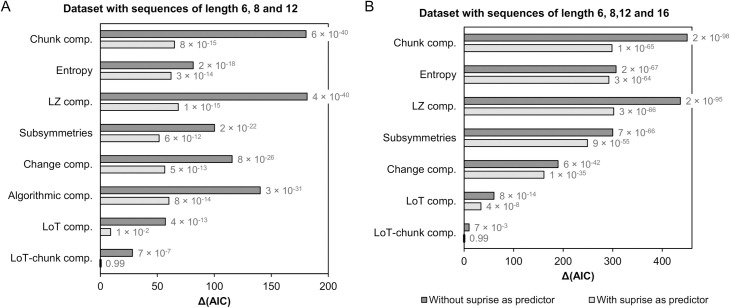
Δ(AIC) for the sixteen mixed models tested using the dataset including the task performance (LISAS) for sequences of length 6, 8 and 12 (A), and for the twelve different mixed models tested using the dataset with sequences of length 6, 8, 12 and 16 (B). The fixed effect of interest is indicated along the vertical axis (all models included participants as a random effect and could include surprise as a covariate—light gray bars). Akaike weight for each model is also reported. The model with lower AIC (Δ(AIC) = 0) is indicated by short dark vertical line on the vertical axis.